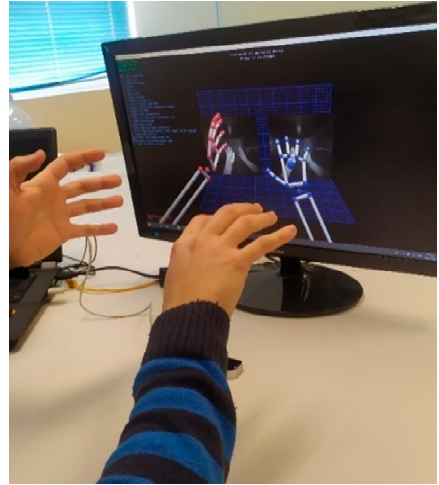
Figure 9. Leap Motion diagnostic tool viewer.